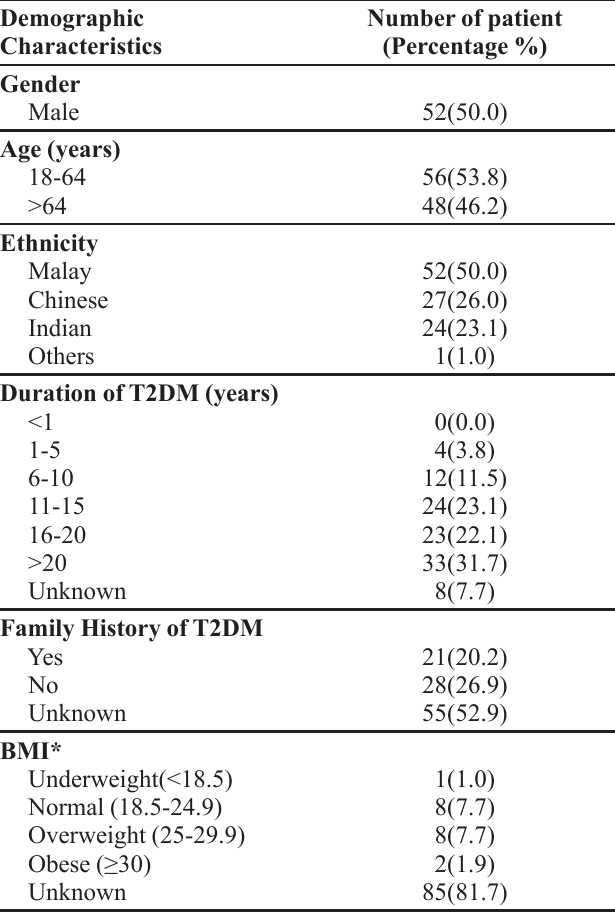
TABLE II - Demographic characteristics of patient